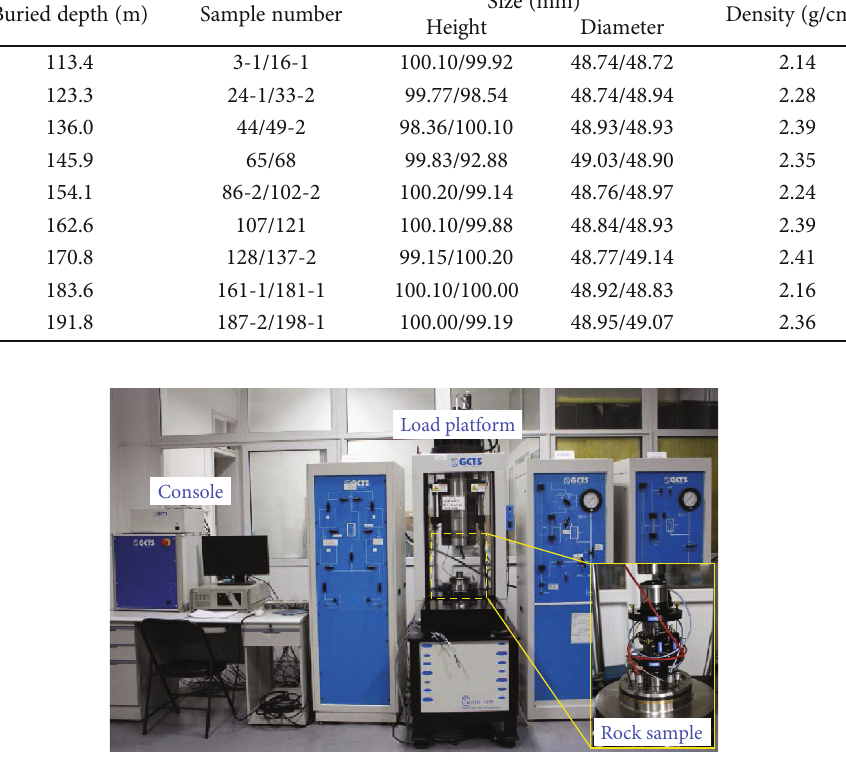
Figure 2: Rapid triaxial rock resting system (RTR-1000).